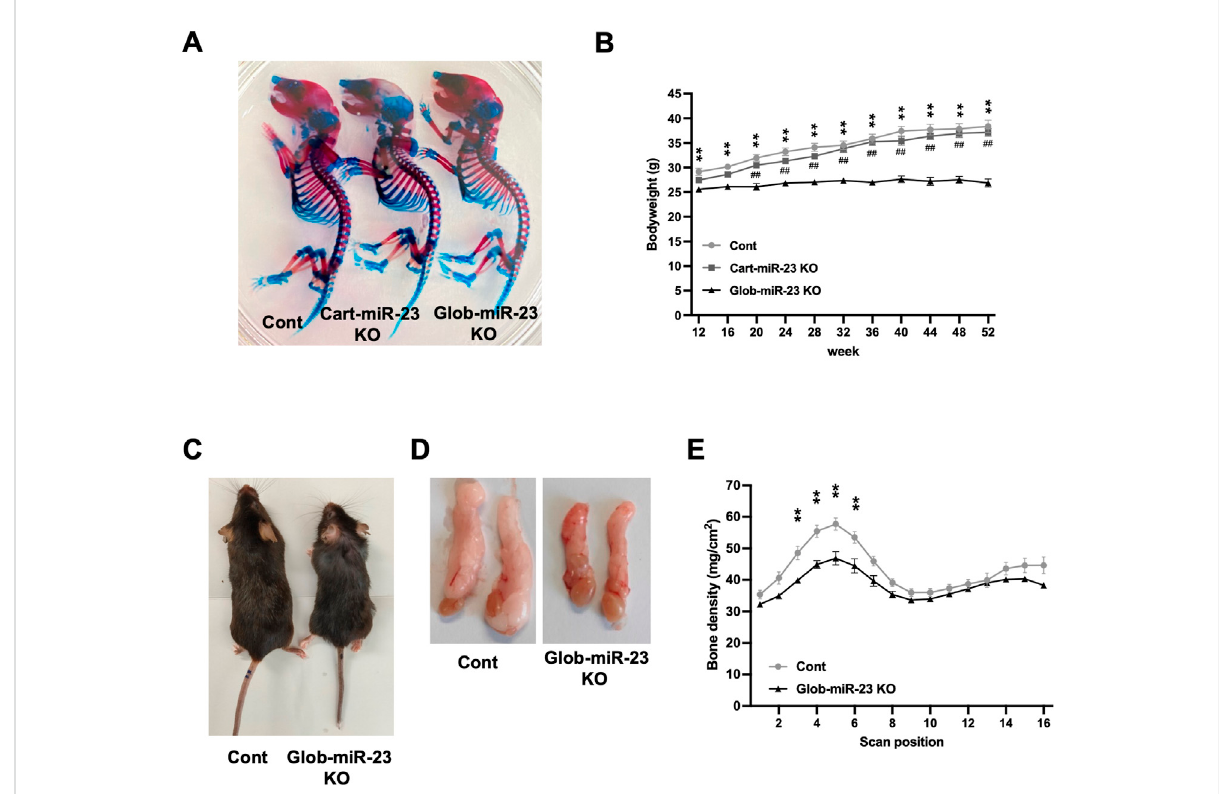
FIGURE 6 Growth retardation and accelerating aging-like phenotype in Glob-miR-23clus KO mice. (A) Skeletal preparation with Alcian blue/Alizarin red stainingofControl,Cart-miR-23clusKO,andGlob-miR-23clusKOmiceatpostnatalday0. (B) Bodyweightduring aging.Glob-miR-23clus KOmice exhibited growth retardationduring aging. Control: n =11,Cart-miR-23clusKO mice: n =7, Glob-miR-23clusKOmice: n =13. (C,D) Representative images ofwhole body andepididymaladiposetissue inControland Glob-miR-23clus KO miceat12 months ofage. (E) Bone mineral density in ControlandGlob-miR-23clusKOmiceat12 monthsofage( n =7eachgroup).Alldatawasrepresentedasmean±SEM.Thedata (B,E) wasanalyzed by two-way ANOVA; ** p < .01:Glob-miR-23clus KO vs. Control, ## p < .01:Glob-miR-23clus KO vs. Cart-miR-23clus